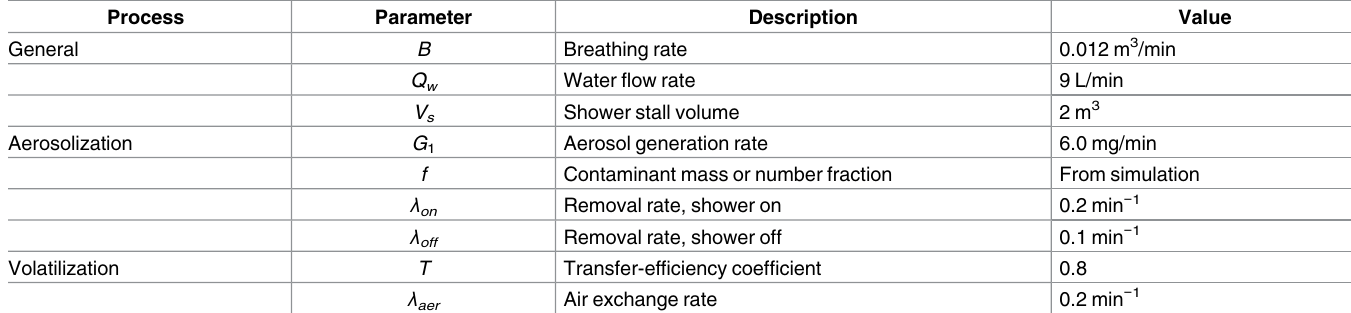
Table 2. Parameters for Showering Models.